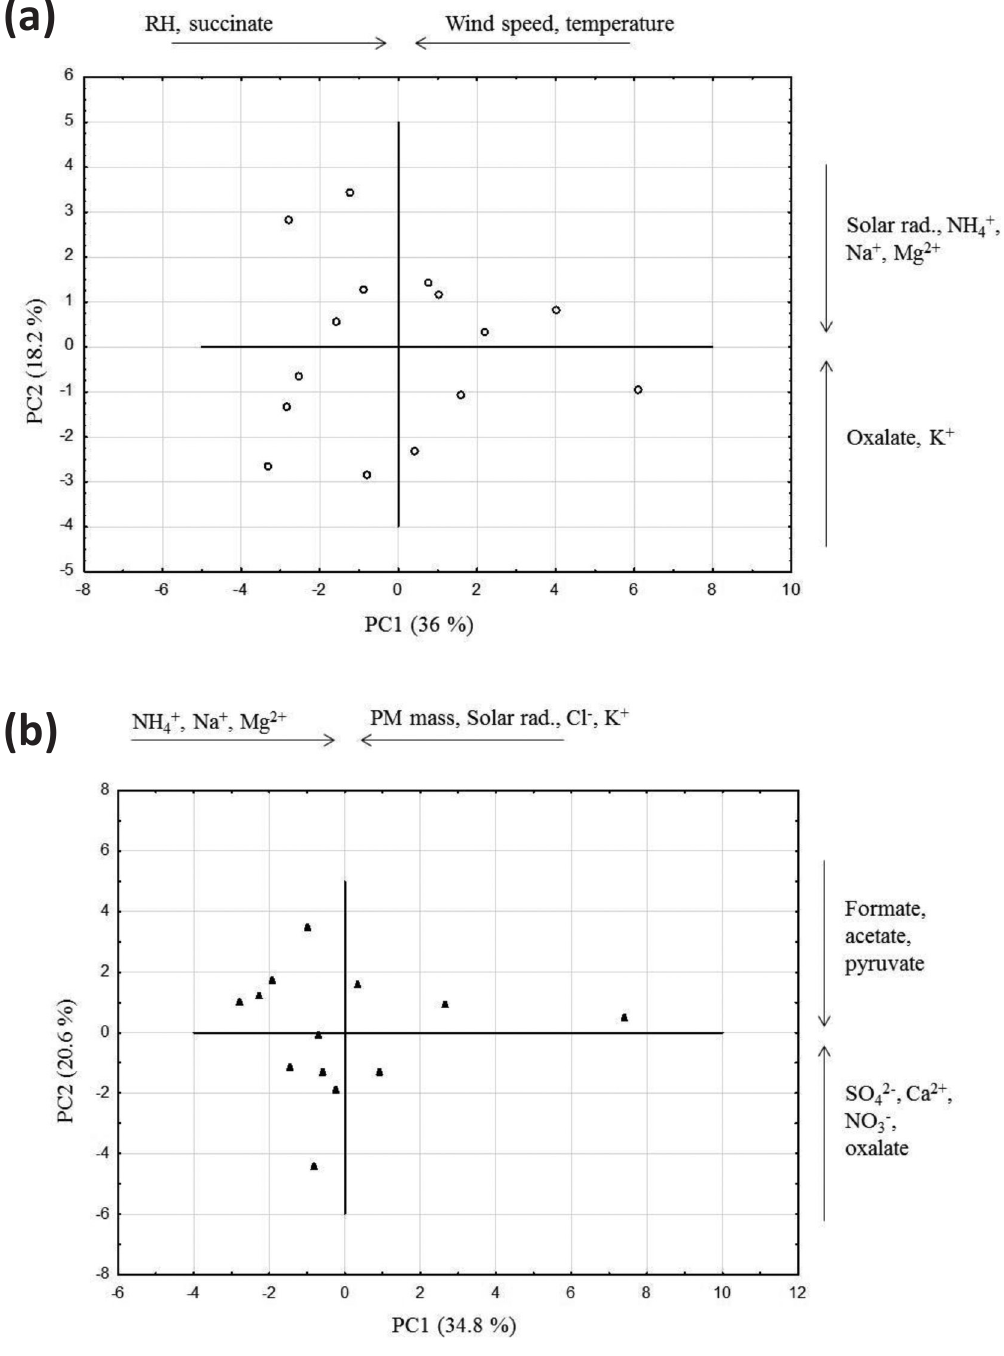
Fig. 5 - Principal component analysis at 95 % confidence level for (a) PM species, from